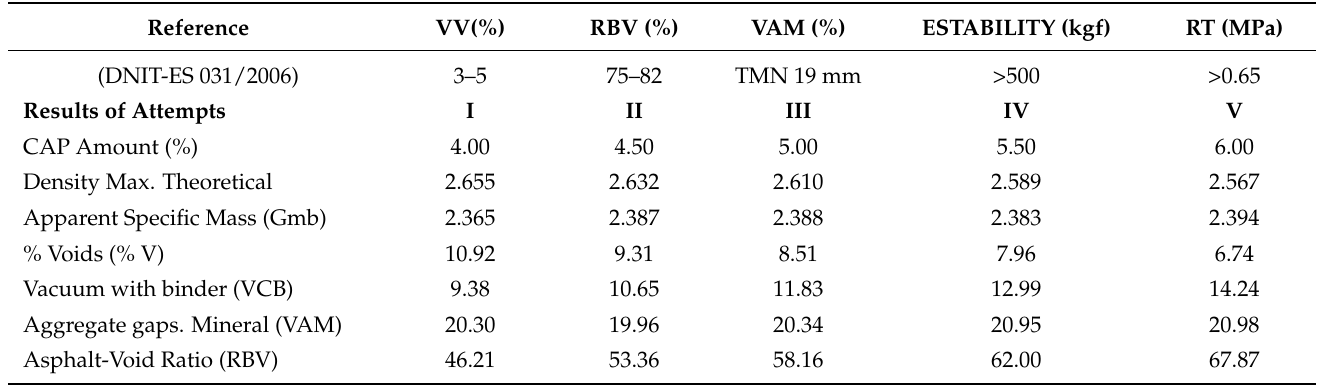
Table 5. Marshall dosing parameters obtained for mixture M1 (without ash) and results of mechanical tests.